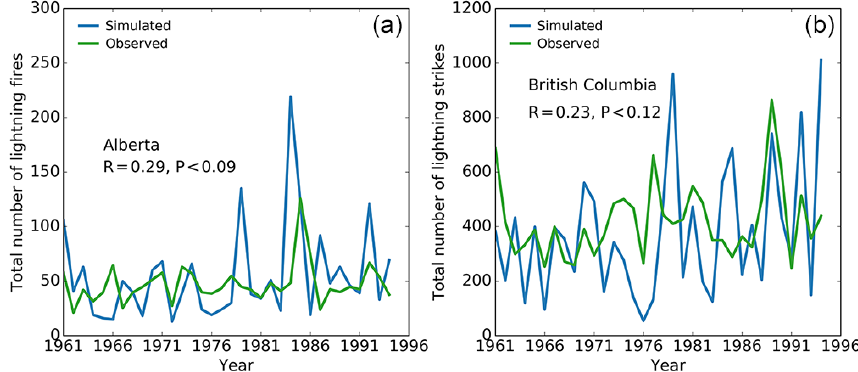
Figure 2. Total number of lightning fires observed (Wierzchowski et al., 2002) and simulated (a) in Alberta and (b) in British Columbia.